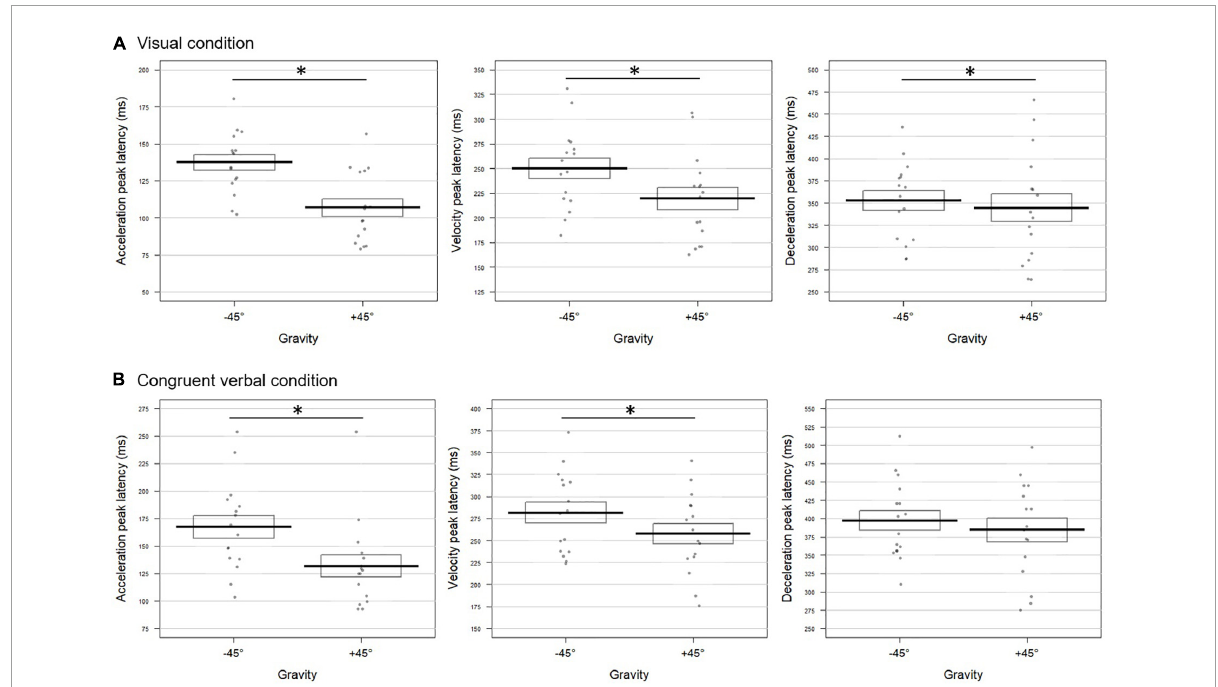
FIGURE2 Gravity effect on the movement tangential profile for (A) visual and (B) congruent verbal instructions in Experiment 1. The bold lines represent peak latencies (in milliseconds) of the acceleration (left panel), velocity (middle panel), and deceleration (right panel) peaks averaged over all participants for movements toward –45 ◦ and +45 ◦ targets. Standard errors are illustrated by rectangles. Each dot represents the mean peak latency for one participant in the corresponding condition. Asterisk indicates a significant difference between conditions. (A) Upon visual instructions, acceleration, velocity, and deceleration peaked earlier for movements toward +45 ◦ than –45 ◦ targets ( t = –7.72; p = 0.0004; t = –5.51; p = 0.0004; t = –2.42; p = 0.030, respectively). (B) For congruent verbal instructions (“en haut à droite”/ up right and “en bas à droite”/ bottom right ), earlier acceleration and velocity peaks were found in the +45 ◦ than in the –45 ◦ condition ( t = –6.65; p = 0.0004 and t = –4.03; p = 0.0028,